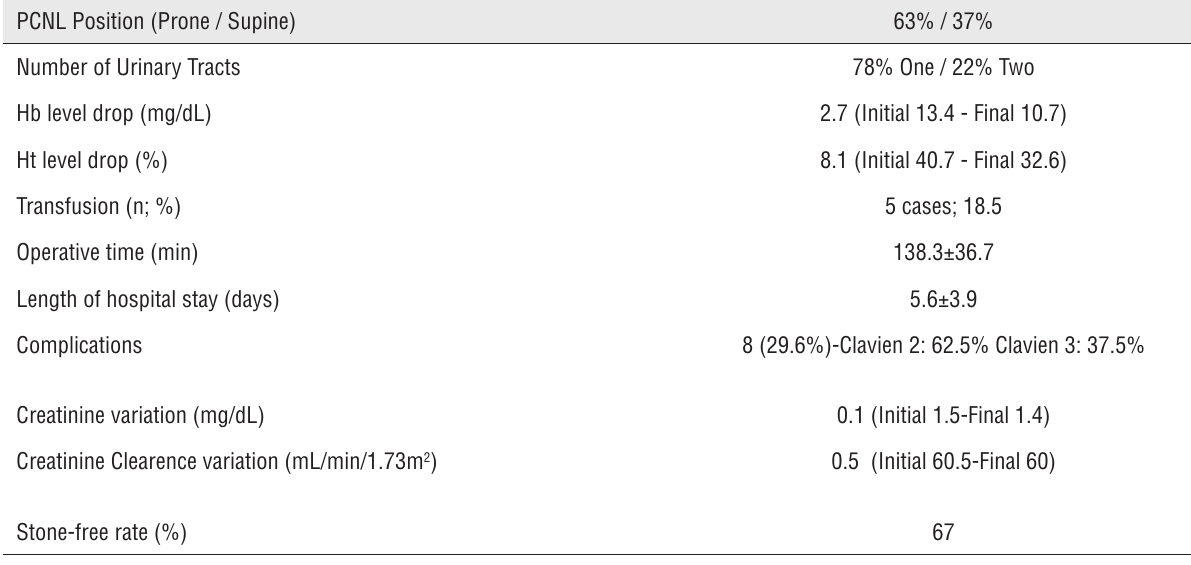
Table 2 - Intra- and postoperative data.